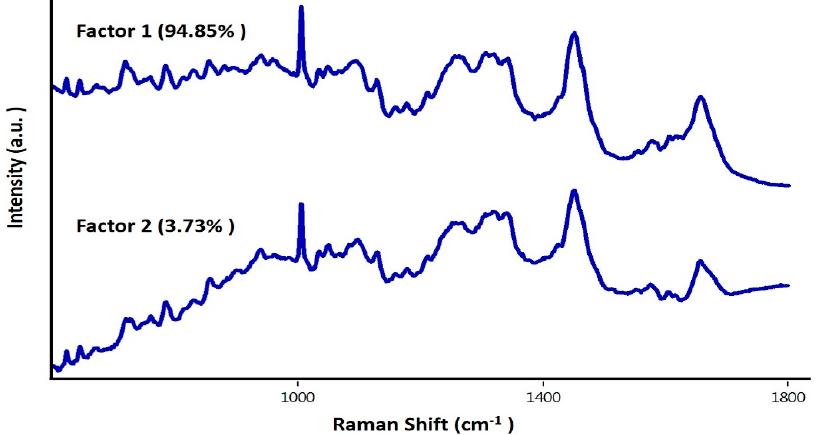
Figure 5. Loading plots of factors used for PCA.